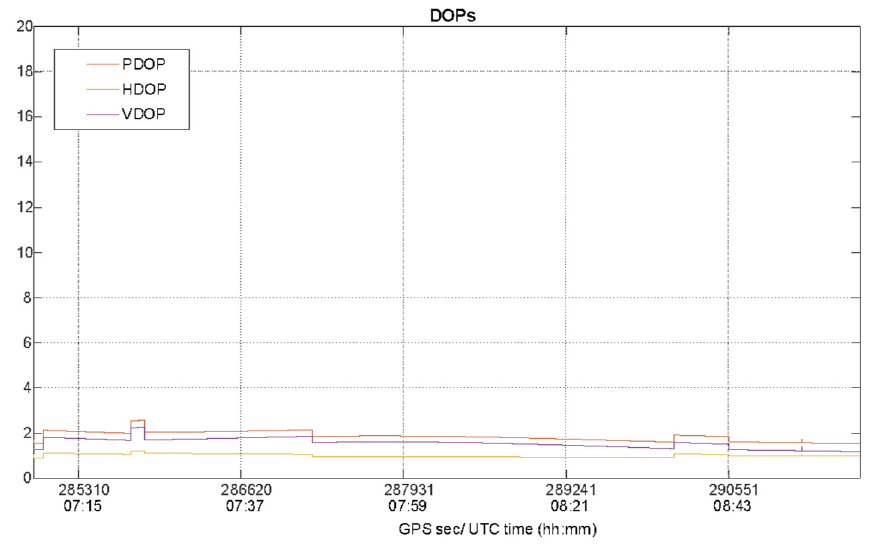
Figure 7. Position Dilution of Precision (PDOP), Vertical DOP (VDOP) and Horizontal DOP (HDOP)values as function of the time during the kinematic test.